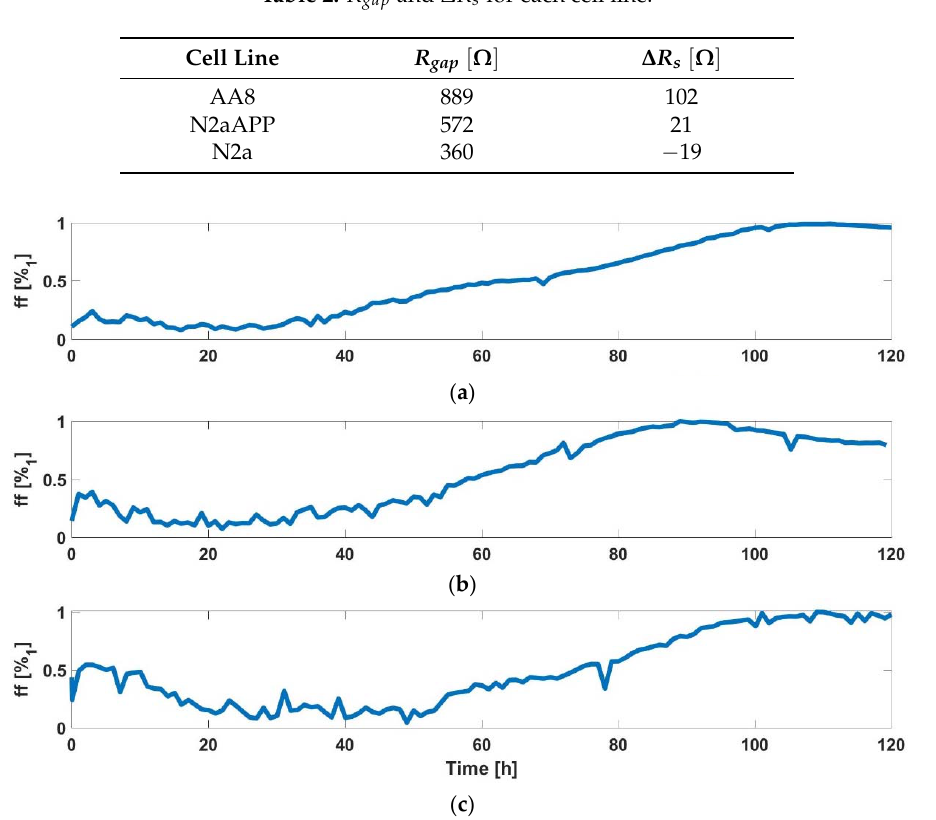
Table 2. (cid:1844) (cid:3034)(cid:3028)(cid:3043) and ∆(cid:1844) (cid:3046) for each cell line.